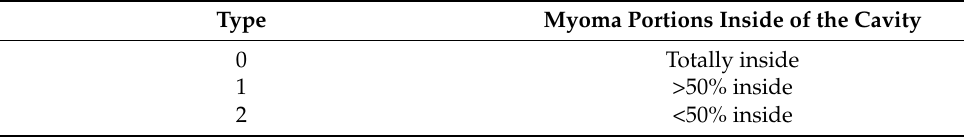
Table 1. ESGE submucous myoma classification—Wamsteker